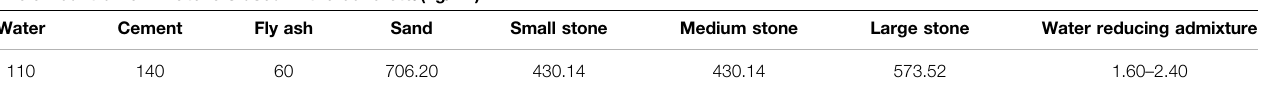
TABLE 2 | Mix proportions of the concrete. The amount of raw materials used in the concrete/(kg/m 3 )